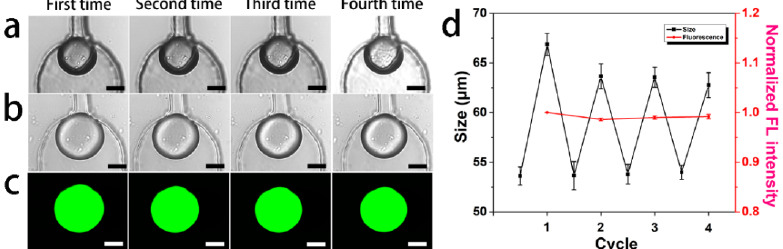
Figure 3. ( a ) Optical microscope images of the dried autofluorescent BSA hydrogel microspheres, ( b ) after injecting water in a trap, and ( c ) the corresponding fluorescence microscope images (all scale bars are 25 μ m); ( d ) cycle number-dependent change of size (black line) and fluorescence intensity (red line) of the autofluorescent BSA hydrogel microspheres. The error bars represent the standard deviation of three measurements. The drying–swelling cycle was repeated four times.